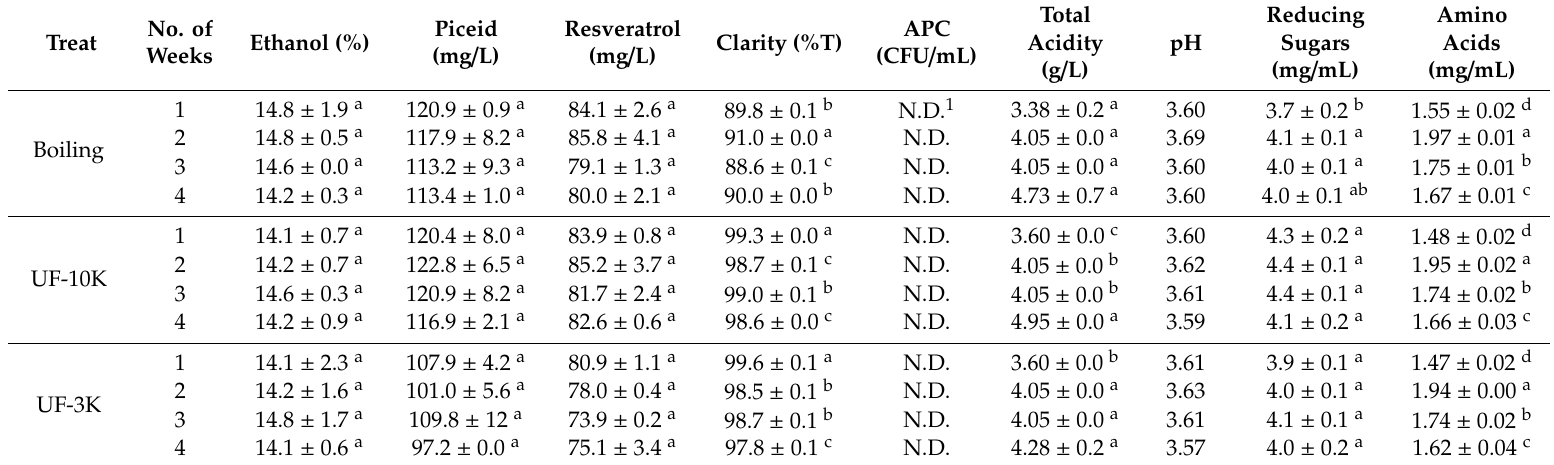
Table 3. Quality characteristics of resveratrol-enriched rice wine treated by boiling and ultrafiltration process after storage.